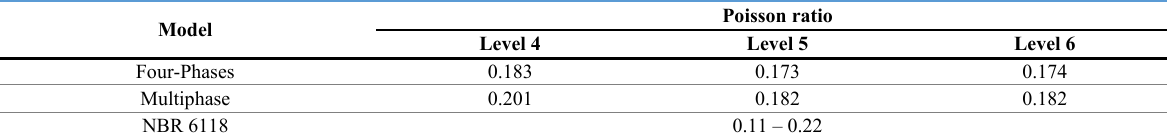
Table 10. Numerical results by homogenization steps for Poisson's ratio (with ITZ).